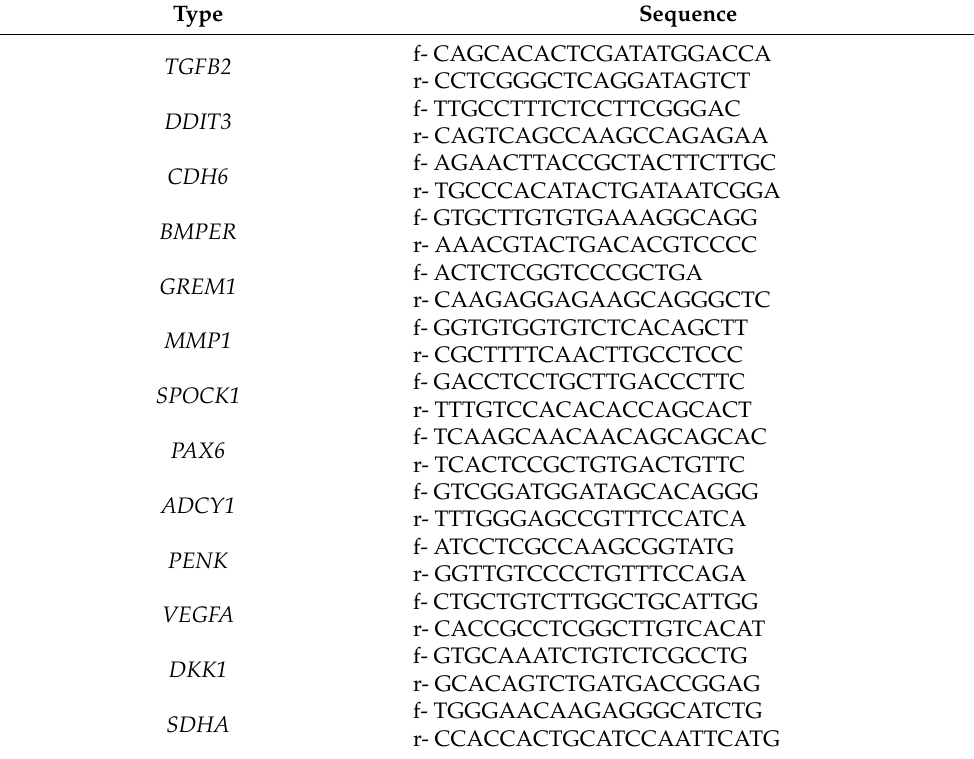
Table 5. Primer sequences used for RT-qPCR validation of select genes identified by RNA-Seq analysis. All sequences are for the human version of each